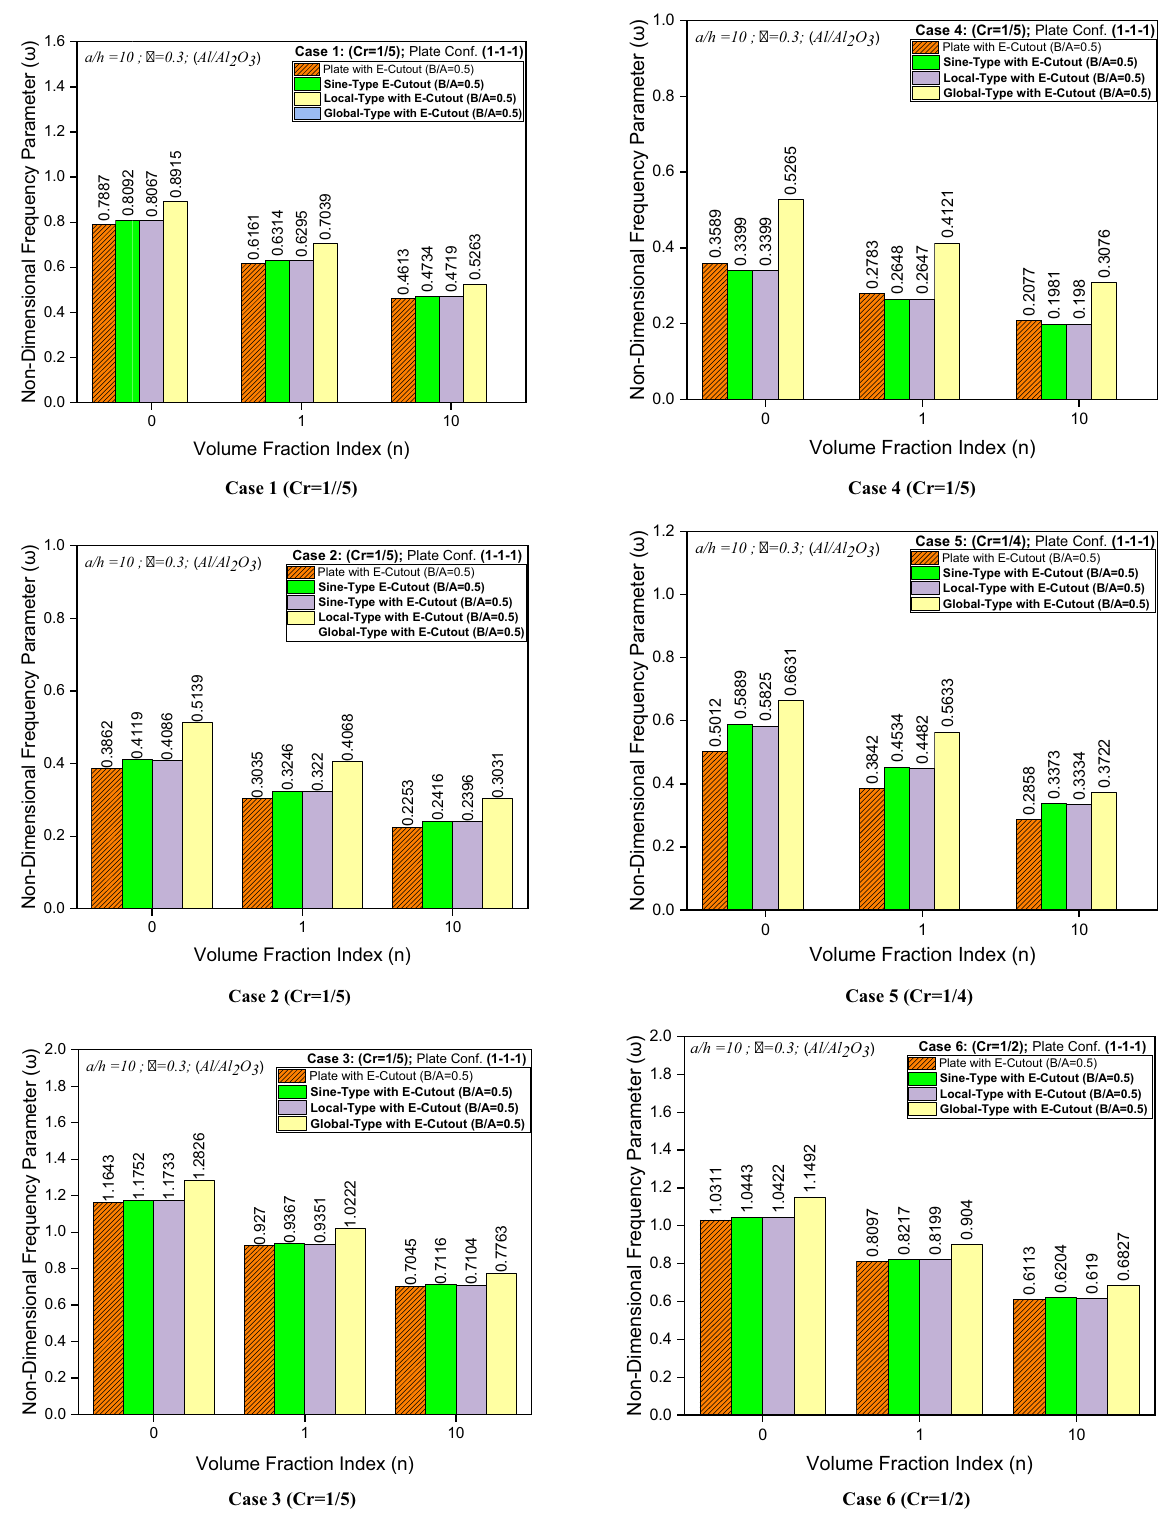
Figure 19: E ff ect of unconventional boundary conditions on the NDFP of SFGM square plate with elliptical cutout along with various imperfection models using ( 1 - 1 - 1 ) con fi